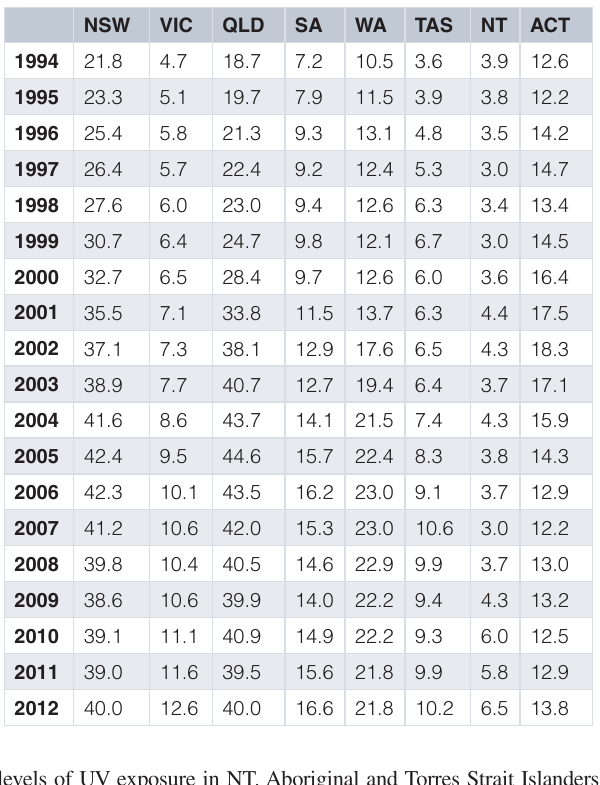
Table 2. Number of AK treatments per 1,000 people for each Australian